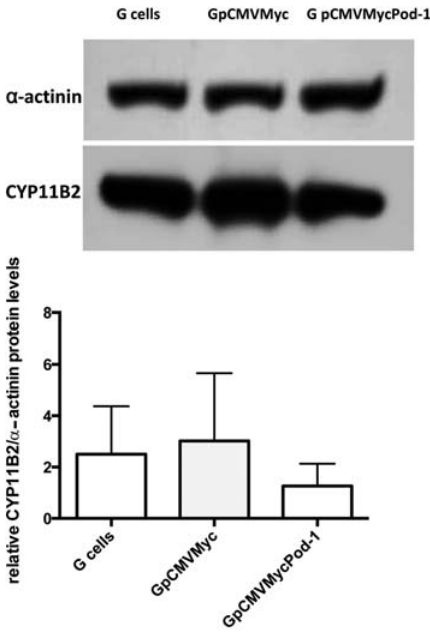
Figure 8. Immunoblotting analyses of relative CYP11B2/ a -actinin protein levels in primary adrenal glomerulosa cells (G cells), untransfected G cells, and G cells transiently transfected with the empty vector pCMVMyc or with pCMVMycPod-1. Protein samples were prepared 72 h post-transfection. Data are reported as the means ± SD from three experiments. Statistical signi fi - cance was assessed by paired t -tests between cells transfected with pCMVMycPod-1 or empty vector